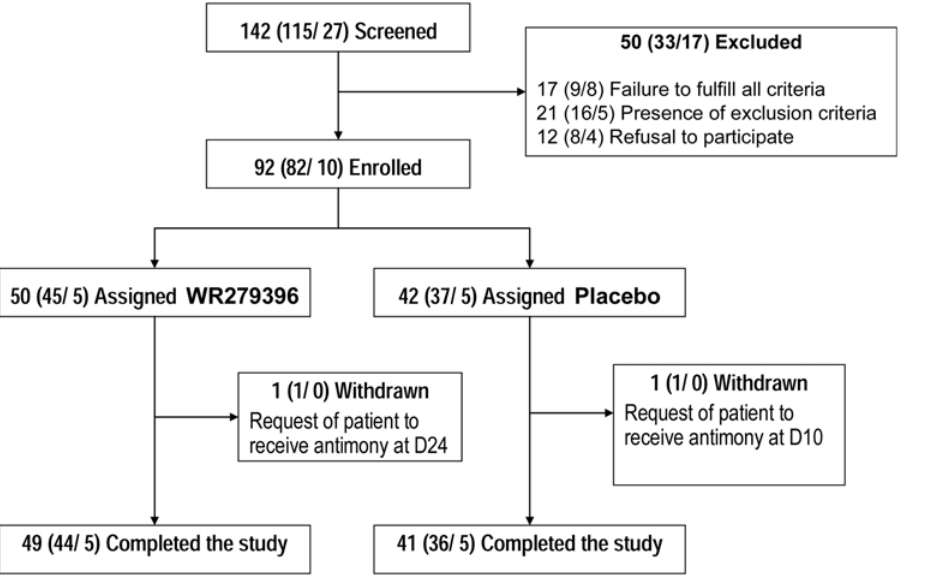
Figure 1. Flowchart summarizing the enrolment, randomization and follow-up of patients. Values are numbers of patients as follows: Total number of patients (Number at Tunisian site/number at French site).